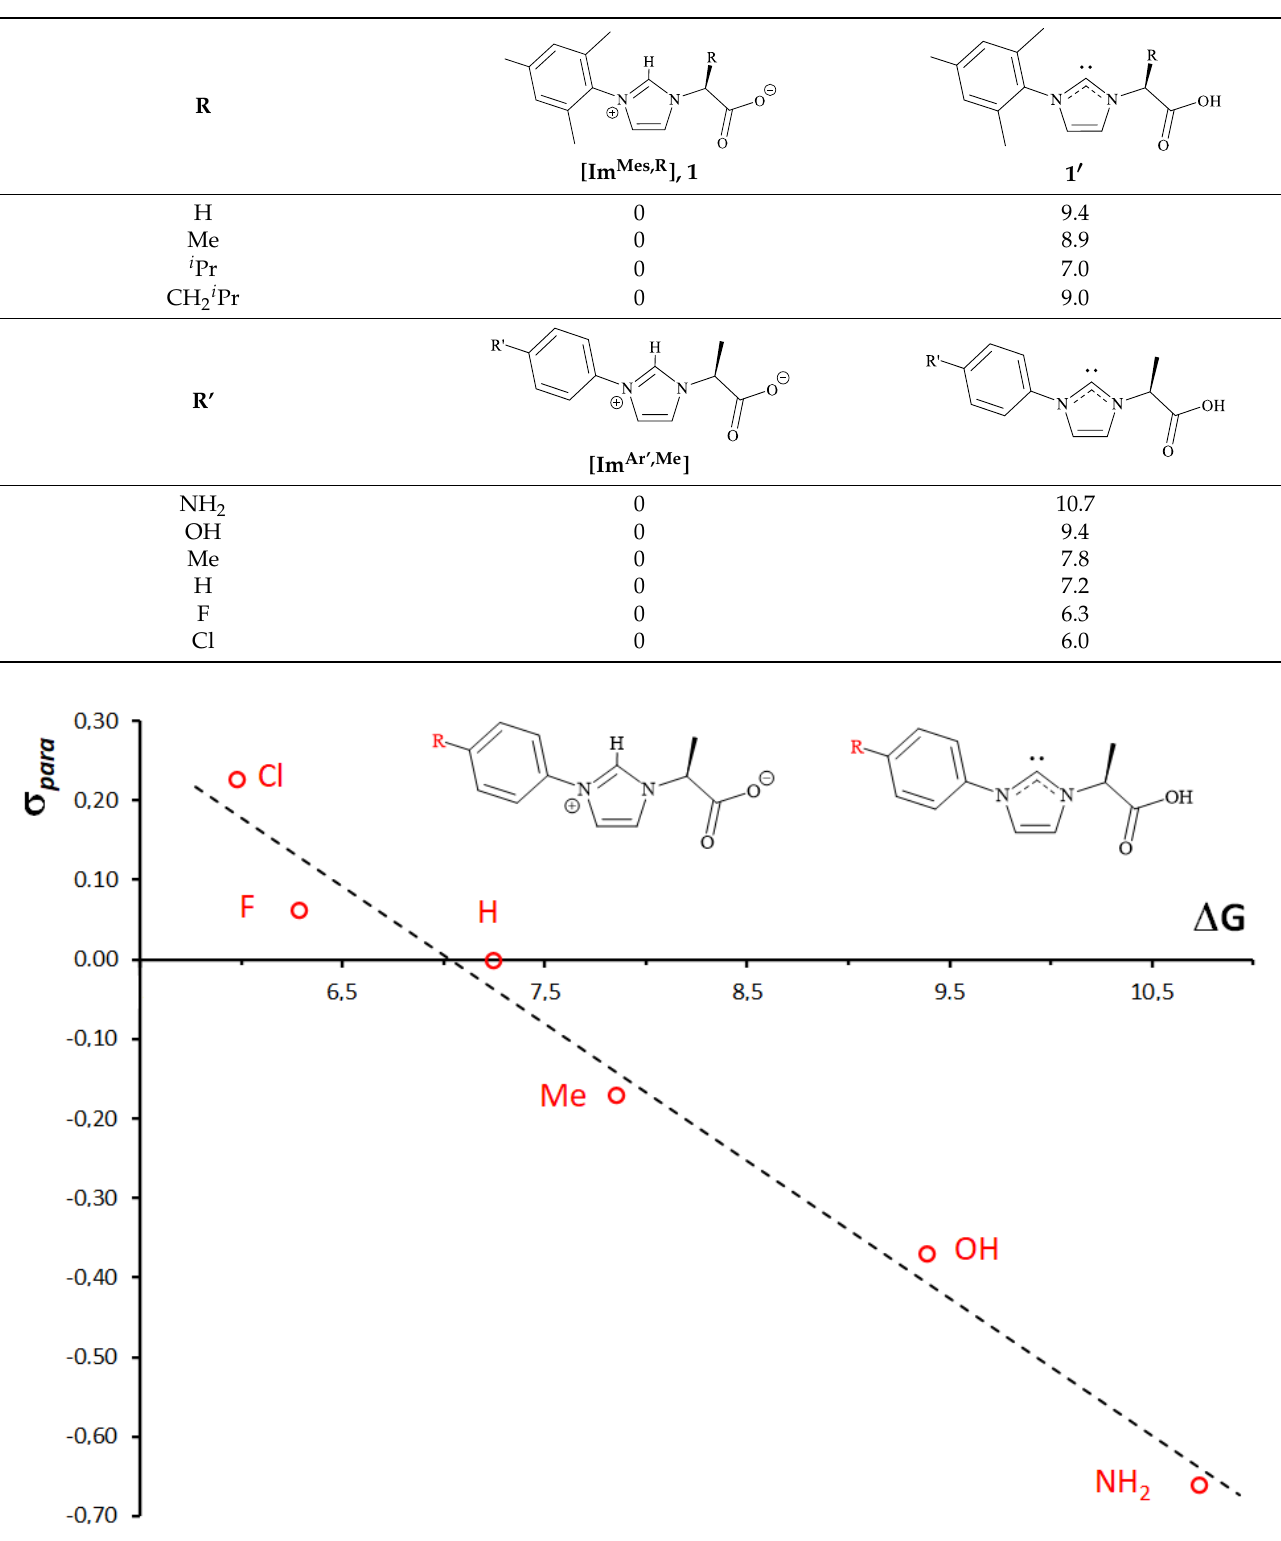
Figure 2. Correlation between the Hammett parameter of the p -substituent of the aryl group and the relative energy difference between the carbene isomer and the stable form of [Im Ar’,Me ]. To simulate the polymeric nature of these complexes, head-to-tail dimeric models 2a c – 2d c ( c subindex for calculated) were optimised. Figure 3 shows the calculated complex 2a c , while complexes 2b c – 2d c are depicted in Figure S11. The description of the Ag – O and Ag – C bond distances in model 2a c (2.097 and 2.104 Å, respectively) is in perfect agreement with the experimental values for 2a , confirming the suitability of the model choice. Other